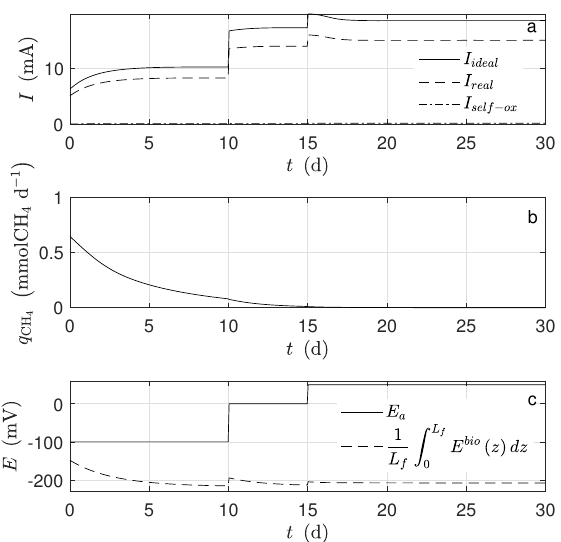
Figure 9. Numerical solution for the MEC model during chronoamperometry operation. ( a ) Current, ( b ) methane production, and ( c ) potential applied and average